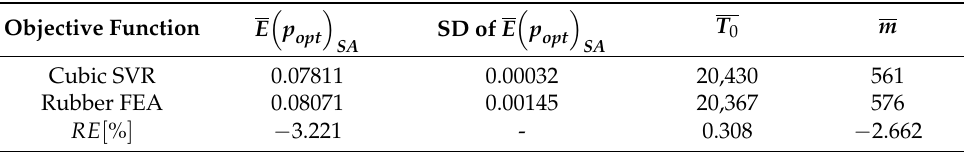
Table 12. Accuracy of the number of iterations and initial temperature determined by the run of the SVR model against the